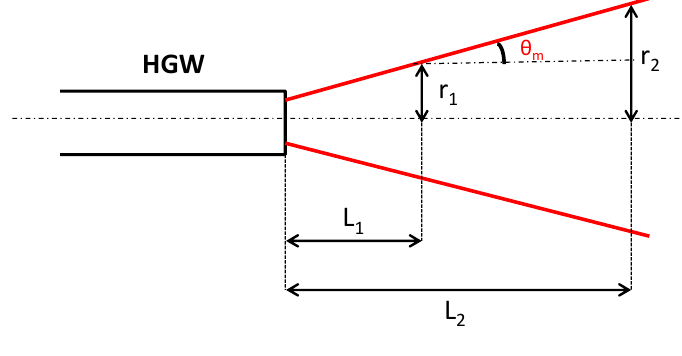
Figure 7. Schematics of the output divergence angle